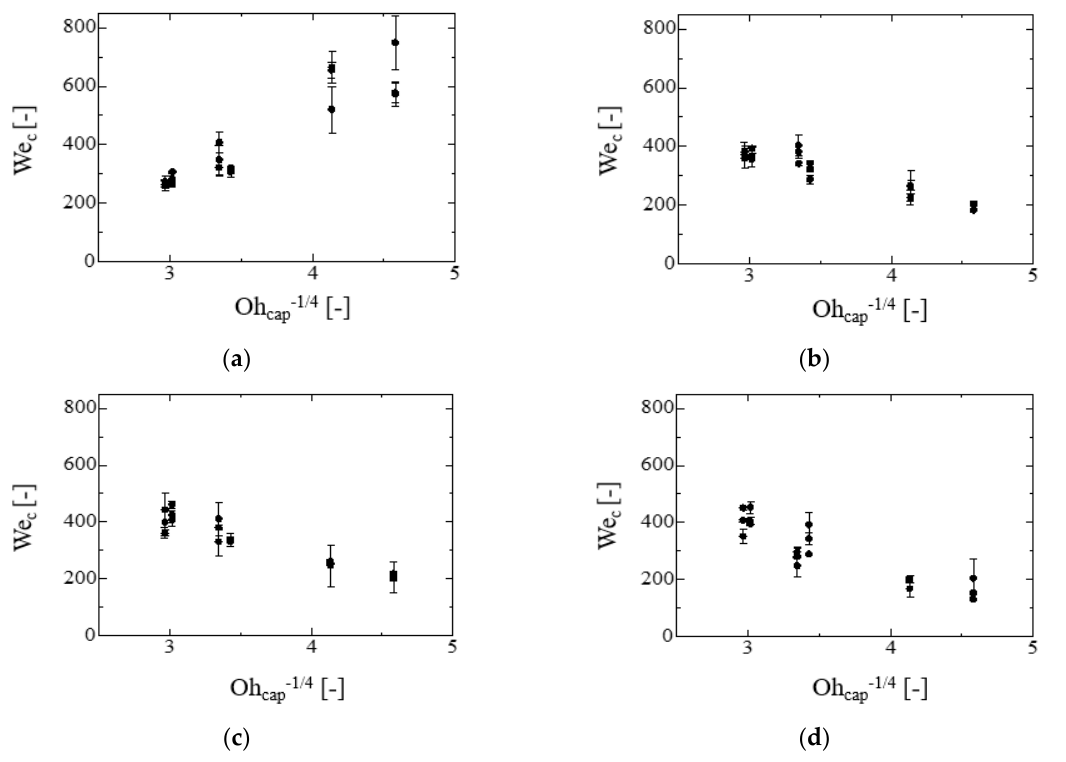
Figure 14. Relationship between We c and Oh cap : ( a ) bare substrate; ( b ) #400 substrate; ( c ) #240 substrate; and ( d ) #120 substrate.